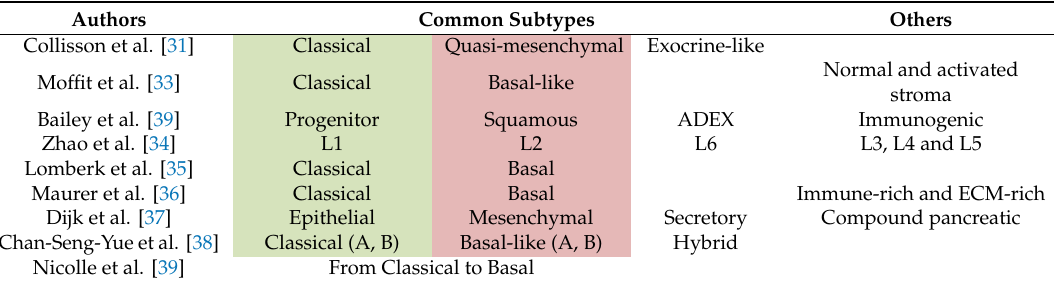
Table 2. Molecular subtypes corresponding to PDAC